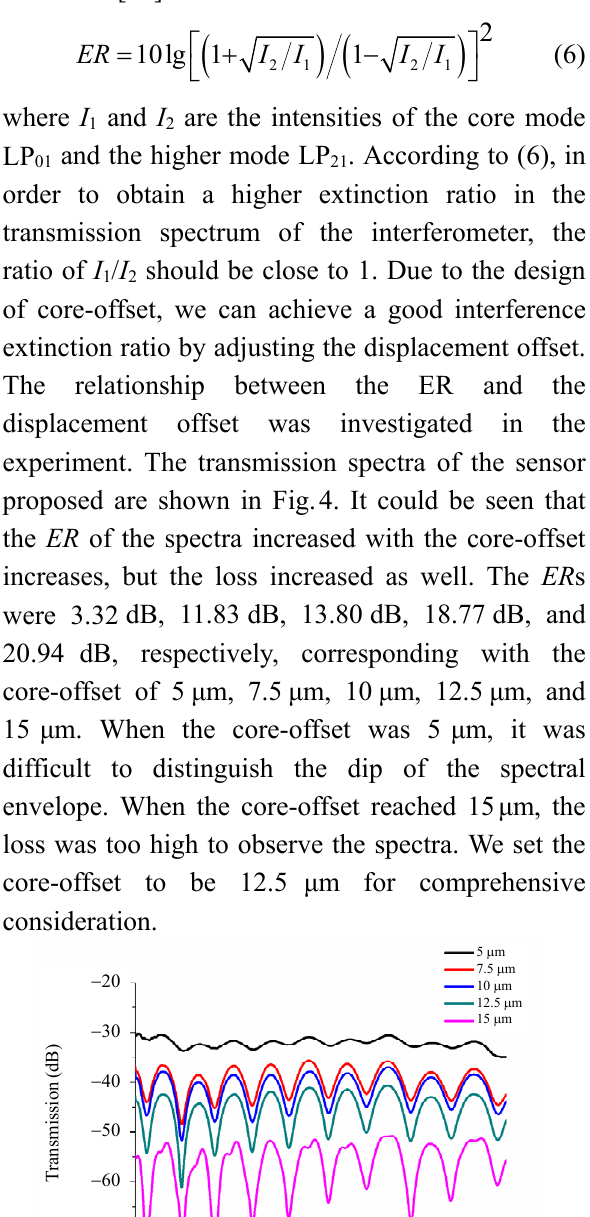
Fig. 3 Simulated interference spectrum and measured transmission spectrum: (a) simulated interference spectrum between mode LP 01 and mode LP 11 , (b) simulated interference spectrum between mode LP 01 and mode LP 21 , (c) simulated interference spectrum between mode LP 01 and mode LP 02 , and (d) measured transmission spectrum. Fig. 4 Transmission spectra with different